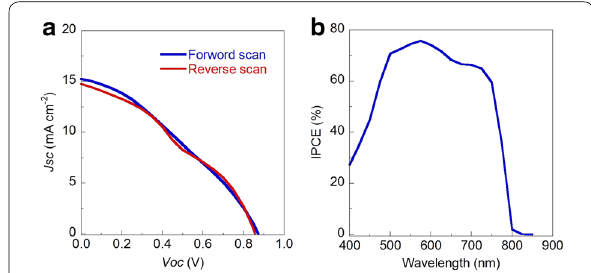
J SC . Cell active area is 3 →